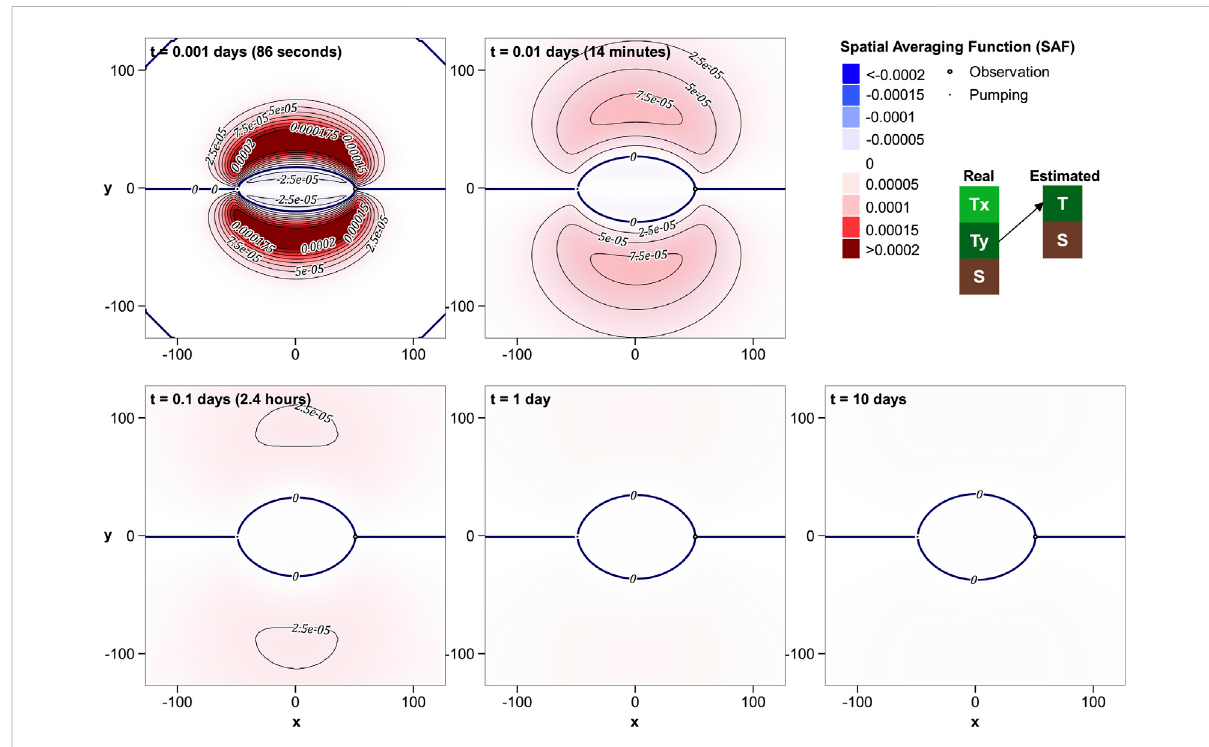
FIGURE 5 R ′ T − Ty for separated wells at fi ve different